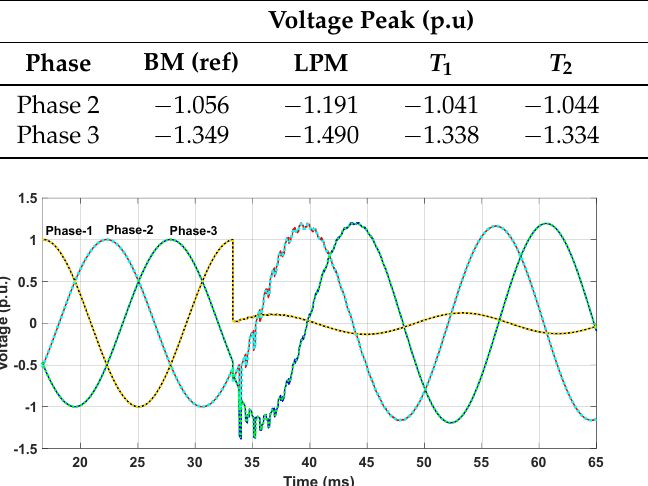
Table 6. Voltage peaks and (cid:101) (%) for each modified topology for scenario 5. Voltage Peak (p.u) (cid:101) (%)